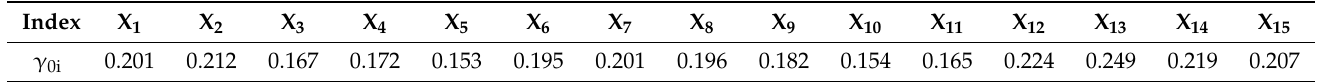
Table 7. Grey weighted relational grade of public space satisfaction indexes of new centralized